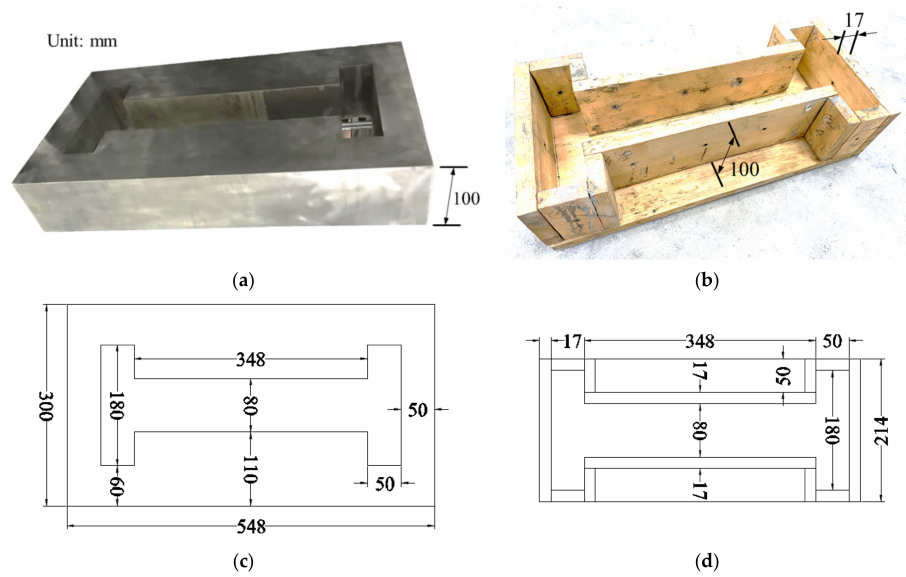
Figure 1. Restraint device, and non-restrained specimen mold. ( a ) Restrained device; ( b ) non- restrained specimen mold; ( c ) the specific dimensions of the top view of the restrained device; ( d ) the specific dimensions of the top view of the non-restrained specimen